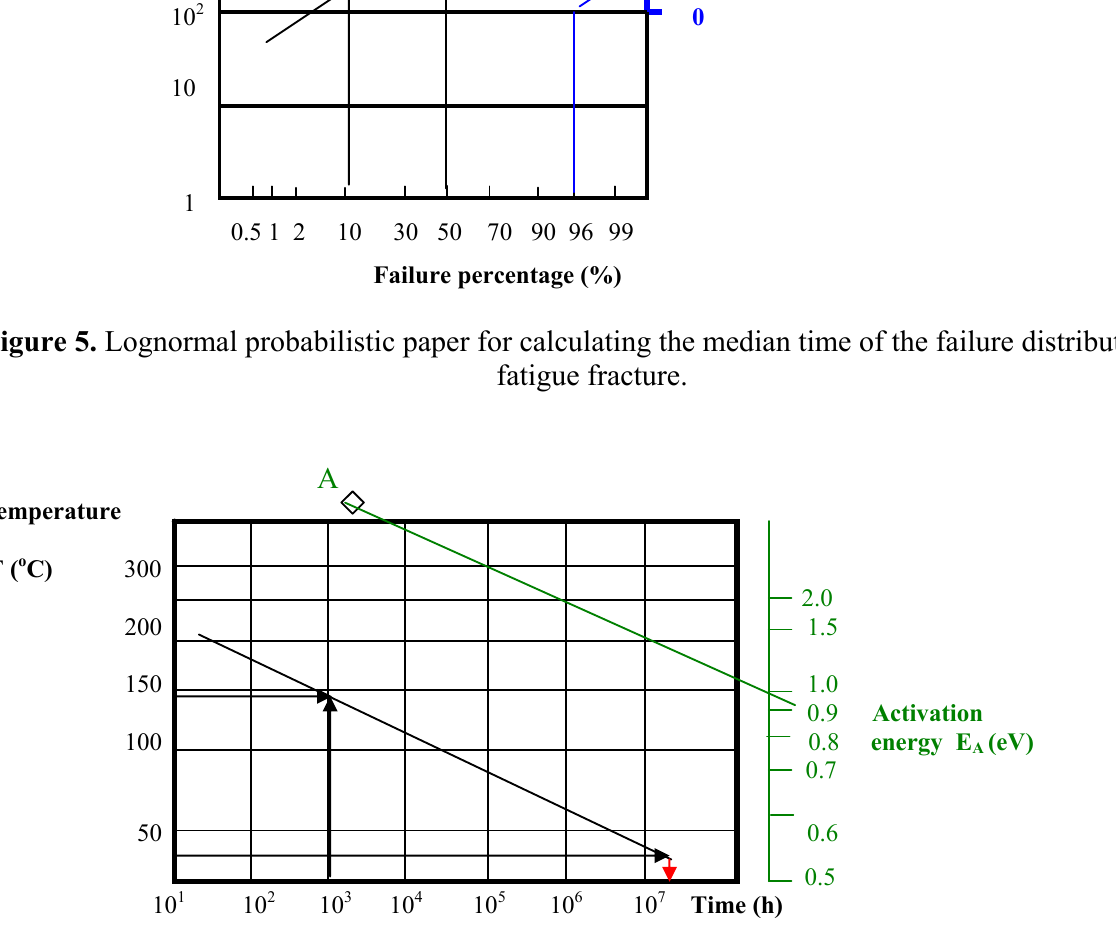
Figure 6. Arrhenius plot for calculating the median life of the failure rate distribution at 25 o C, for the batch of MEMS accelerometers affected by fatigue fracture